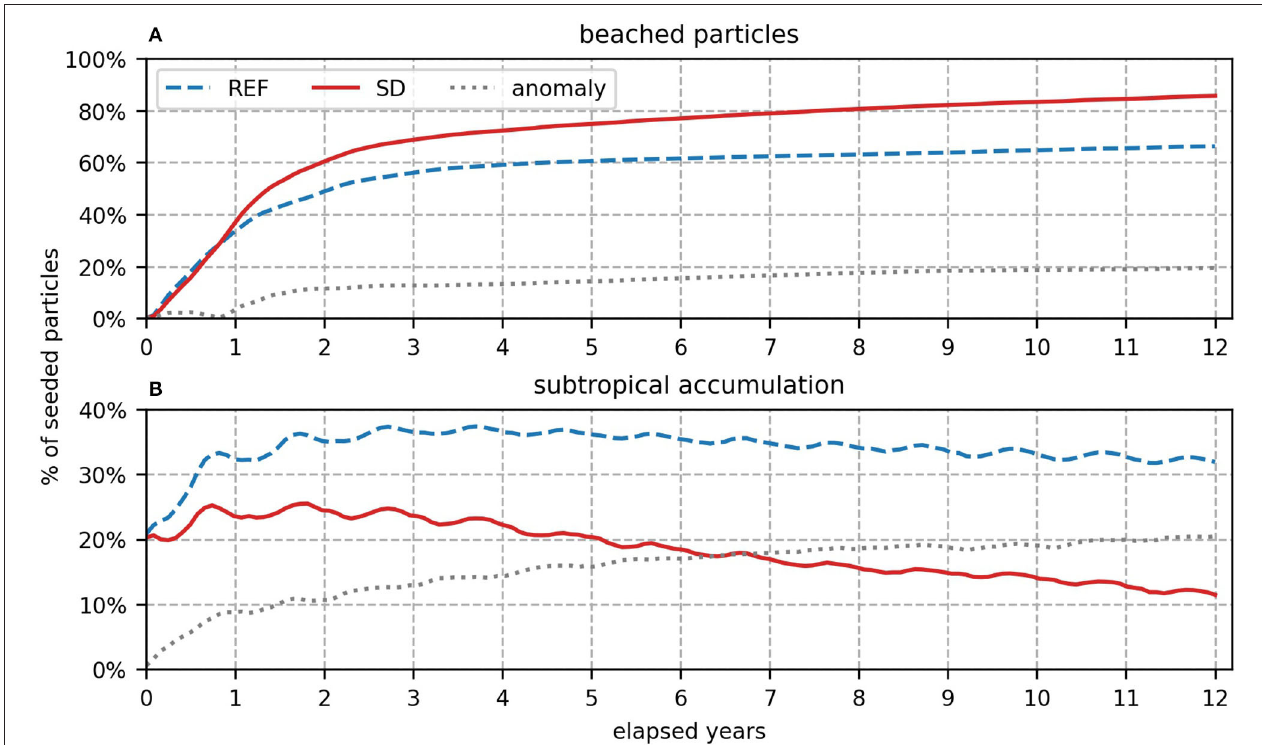
FIGURE 4 | Amount of beached particles over time (A) and of particles located within the subtropical accumulation zone (B) . Quantities are shown in percentage relative to the total number of particles seeded. Beached particles are detected as described in section 2.2. The subtropical accumulation zone is defined as a box with longitude between 70 and 18 ◦ W and latitude between 21 and 42 ◦ N. Data points are taken every 30